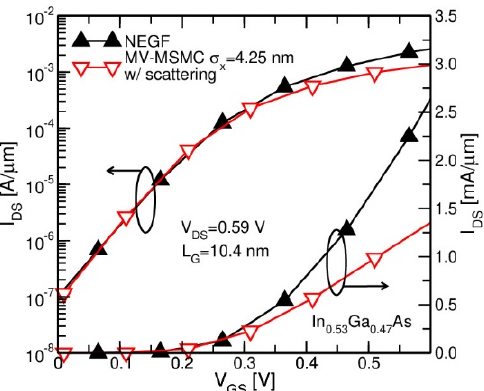
Figure 10. Comparison of I DS -V GS between NEGF and MV–MSMC including scattering. In 0.53 Ga 0.47 As device with 10.4 nm gate length. V DS = 0.59 V. Simulation with scattering includes also wave function penetration.